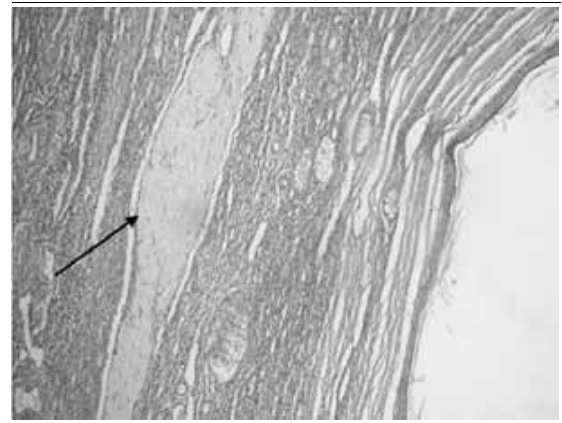
figurE 2 – Microphotograph displaying transition of testicular tissue and adjacent cystic formation with squamous lining (arrow) (HE, 100×) HE: hematoxylin and eosin.